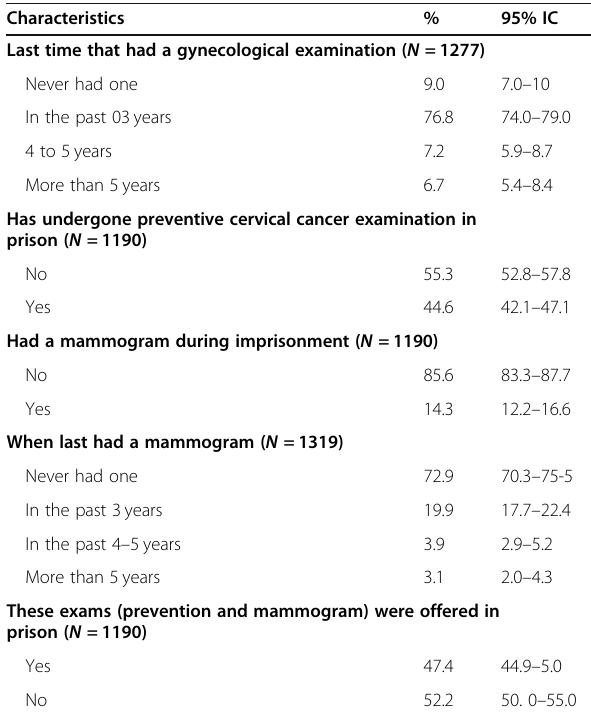
Table 3 Access to healthcare service of women incarcerated